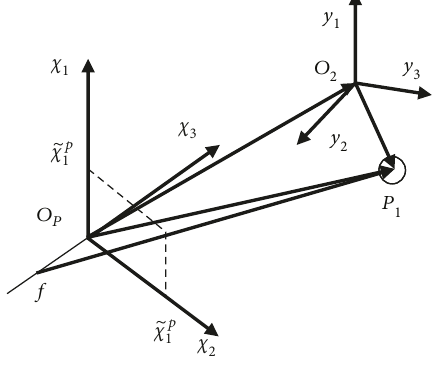
Figure 2: Camera reference frame.